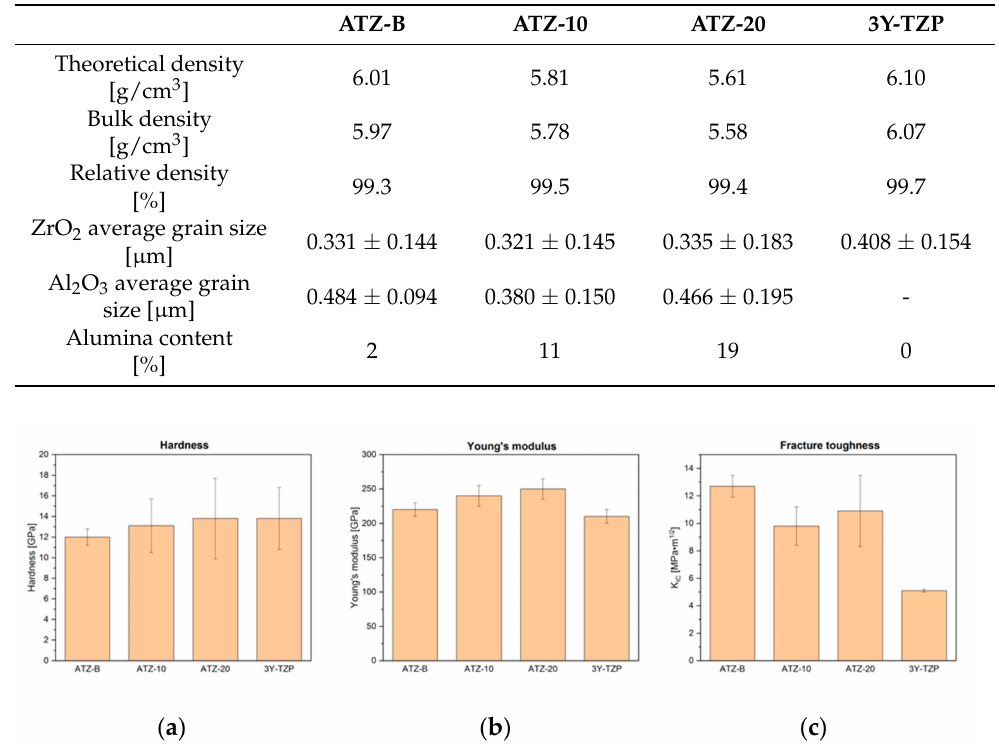
Figure 2. Mechanical properties of the investigated ATZ ceramics (not LTD): ( a ) hardness, ( b ) elastic modulus and ( c ) fracture